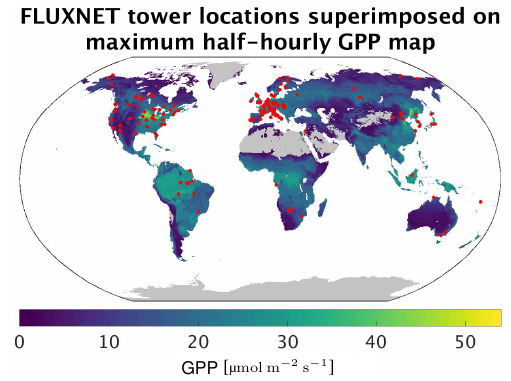
Figure A1. The superimposed FLUXNET tower locations of the sites used in this paper clearly show the biased distribution of under- lying in situ measurements due to better spatial coverage of regions in Europe and North America compared to the rest of the world.